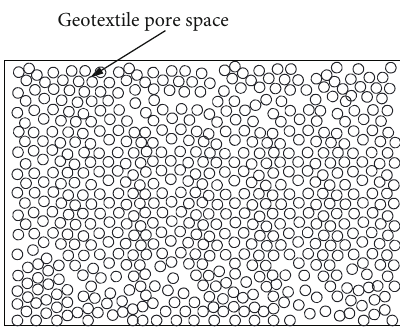
Figure 9: Schematic diagram of pore distribution of geotextile.